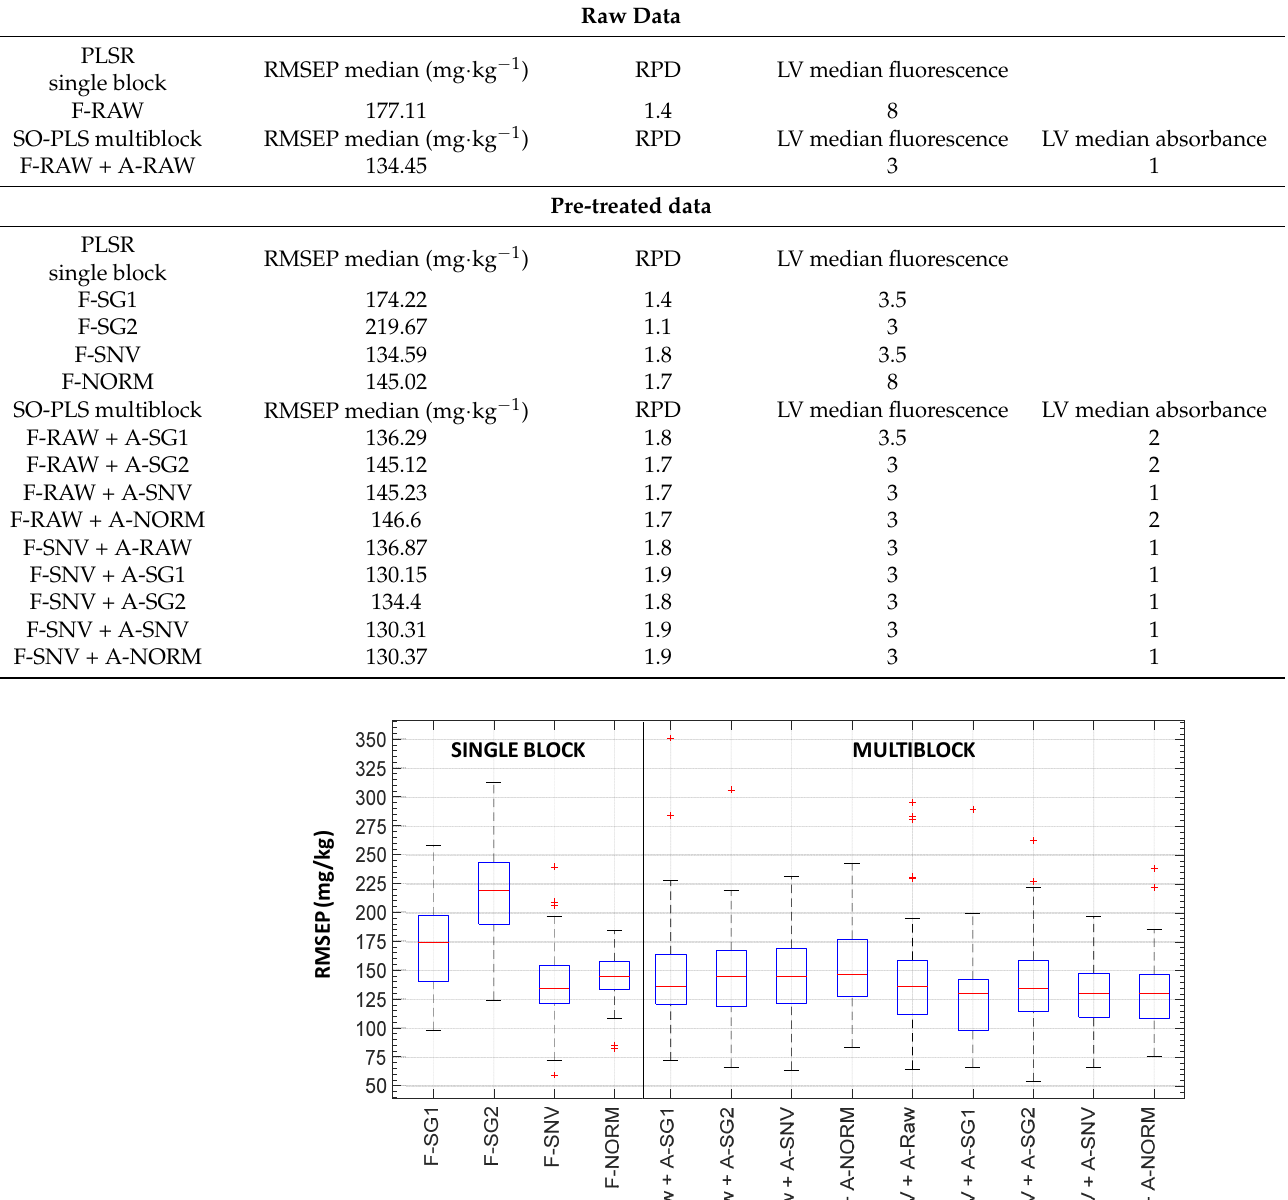
Table 3. Summary of performances of the PLSR single-block and SO-PLS multiblock models for the estimation of total polyphenol content in mg · kg − 1 using different pretreated spectral data.